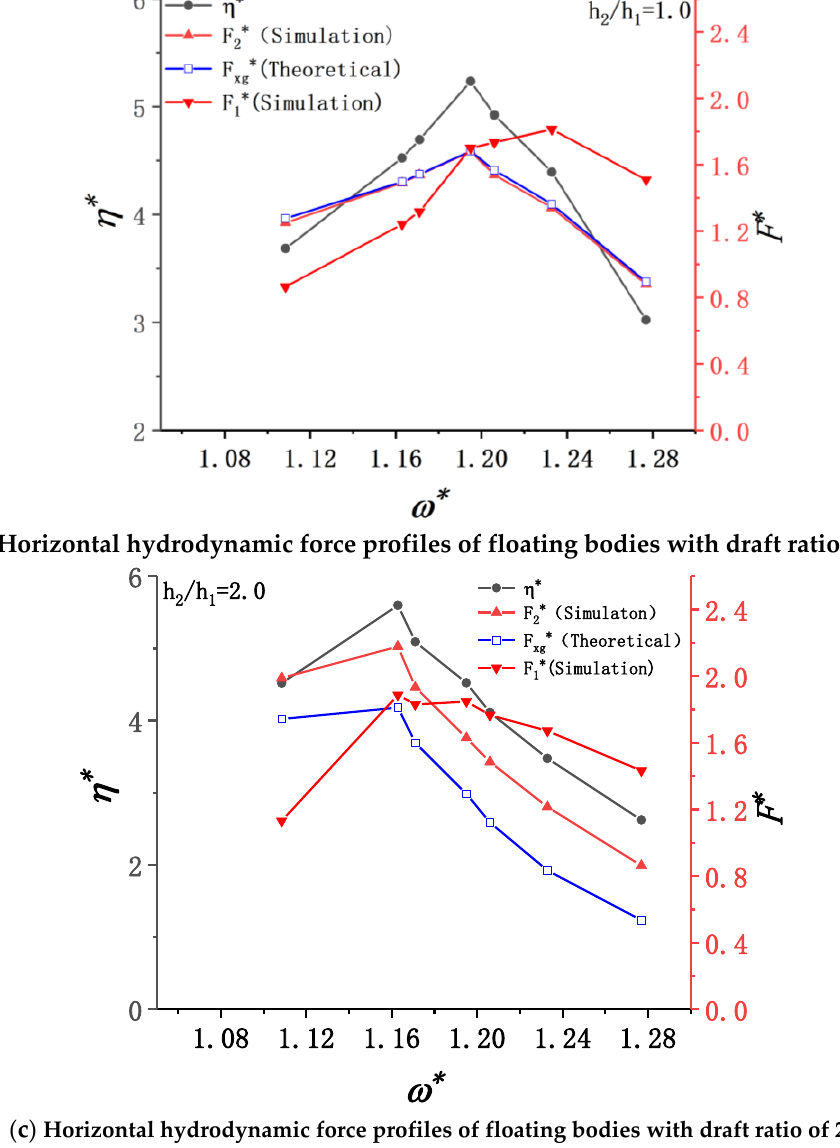
Figure 12. Comparisons of oscillation amplitude of narrow slot fluid and horizontal forces of floating bodies. ( a ) h 2 / h 1 = 0.5, ( b ) h 2 / h 1 = 1.0, ( c ) h 2 / h 1 =